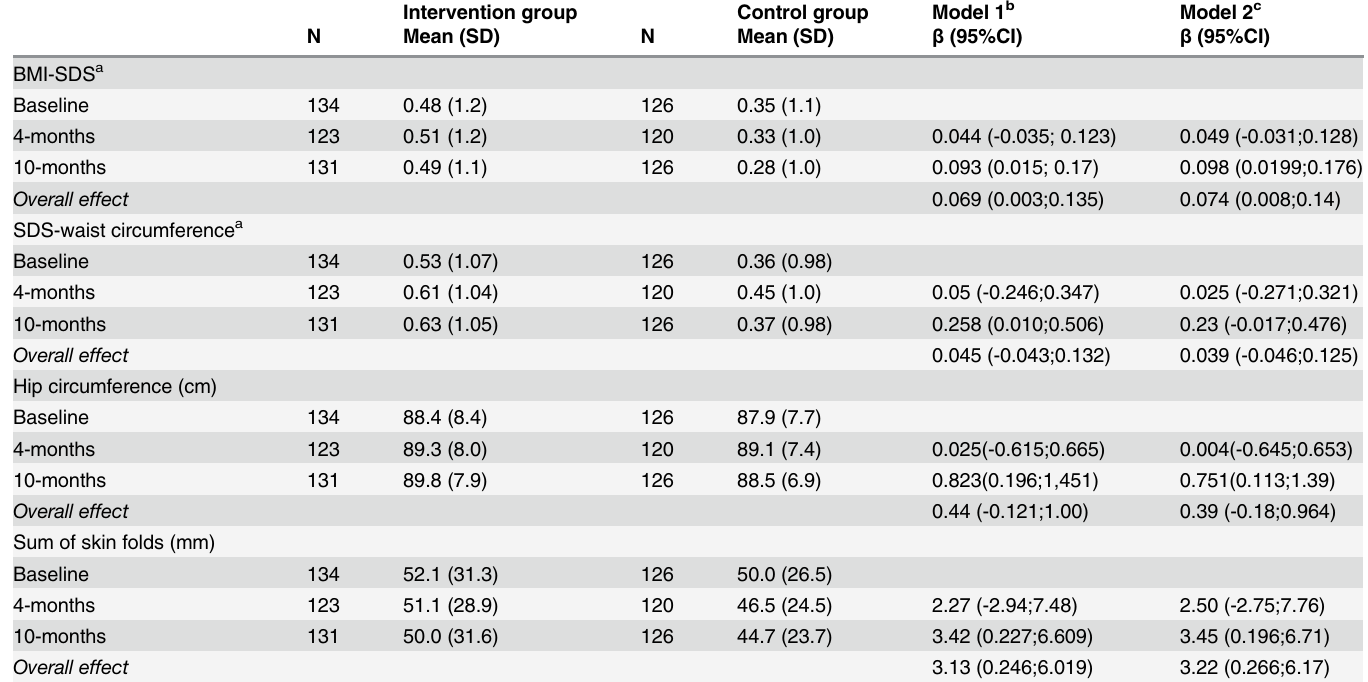
Table 2. Results of main multilevel regression analyses ( β (95% CI)) to evaluate the effects of the active game intervention on anthropometrics after 4 and 10 months (statistical significant β with their 95%CI ’ s are printed in bold).